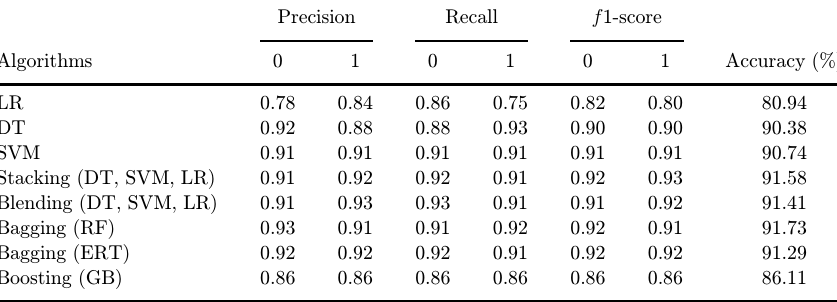
Table 3. Performance results before applying